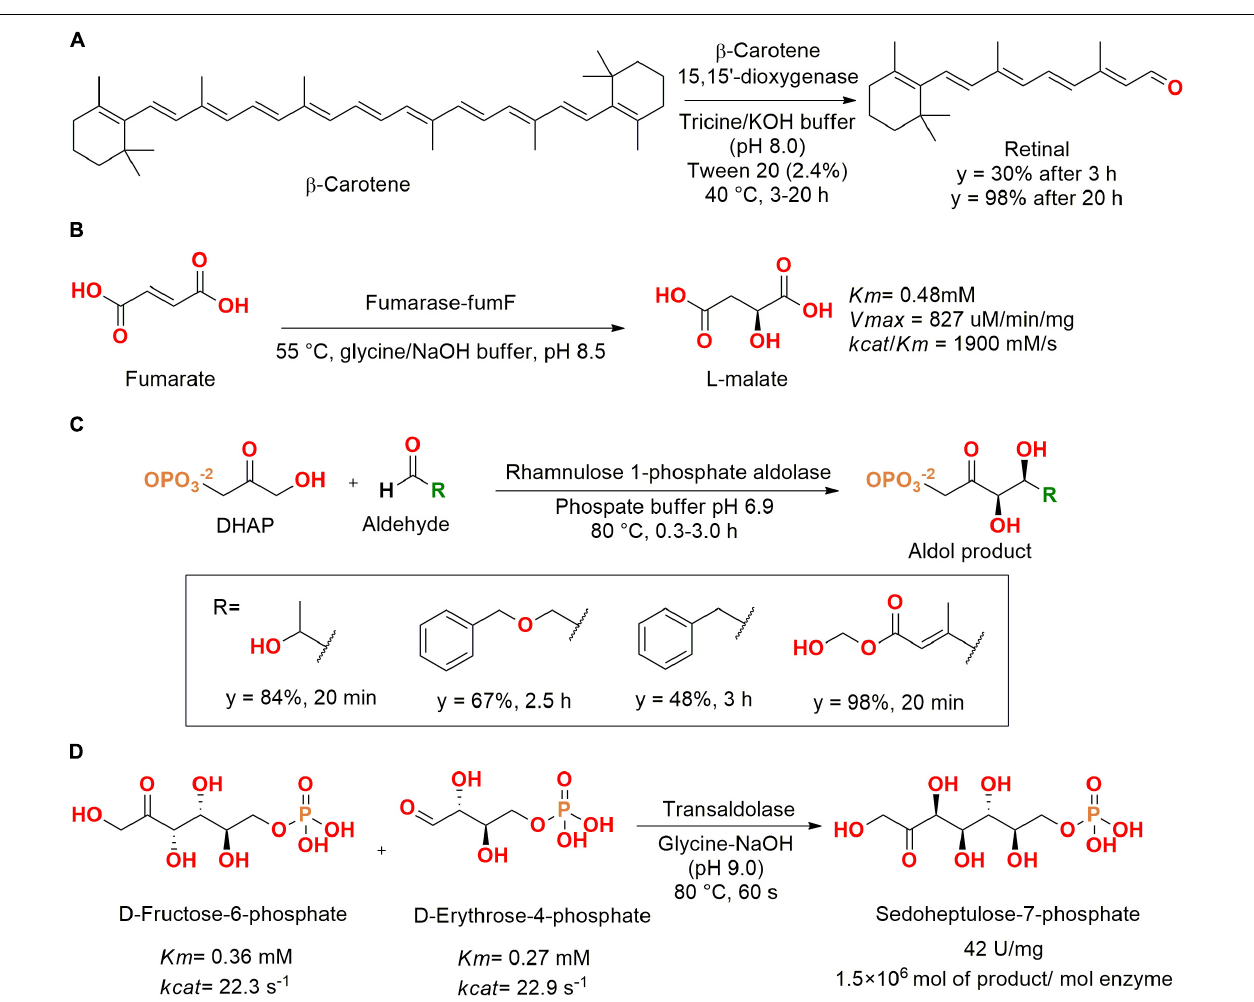
FIGURE 14 | (A) Production of retinal from β -carotene using a β -carotene 15,15 (cid:48) -dioxygenase (Kim et al., 2010). (B) Obtention of L -malate by hydration of fumarate catalyzed by a fumarase enzyme (Jiang et al., 2010). (C) Aldol reaction by a thermophilic aldolase isolated from T. maritima MSB8 (Oroz-Guinea et al., 2015). (D) Production of sedoheptulose-7-phosphate by a thermophilic transaldolase isolated from T. maritima MSB8 (Huang et al.,